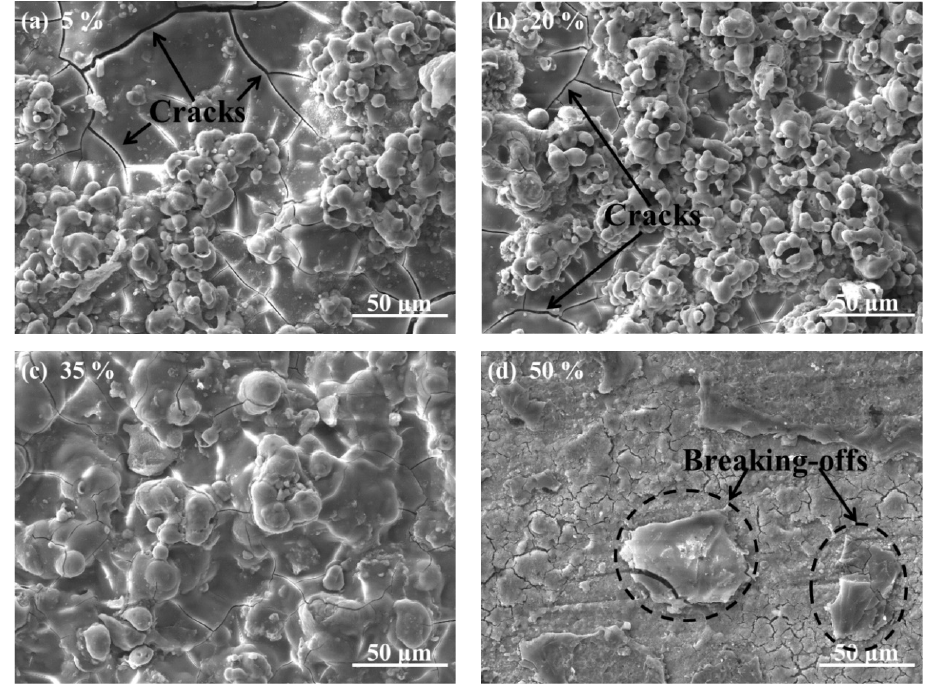
Figure 4. The morphology and the structures of the CPED coatings.